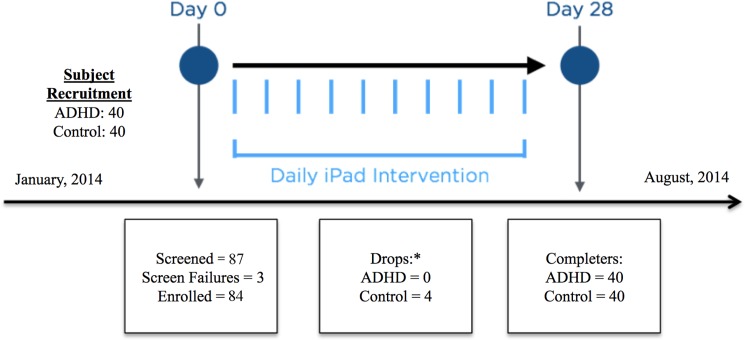
Study design and participant flow.*All participants drop outs were due to noncompliance with the intervention.